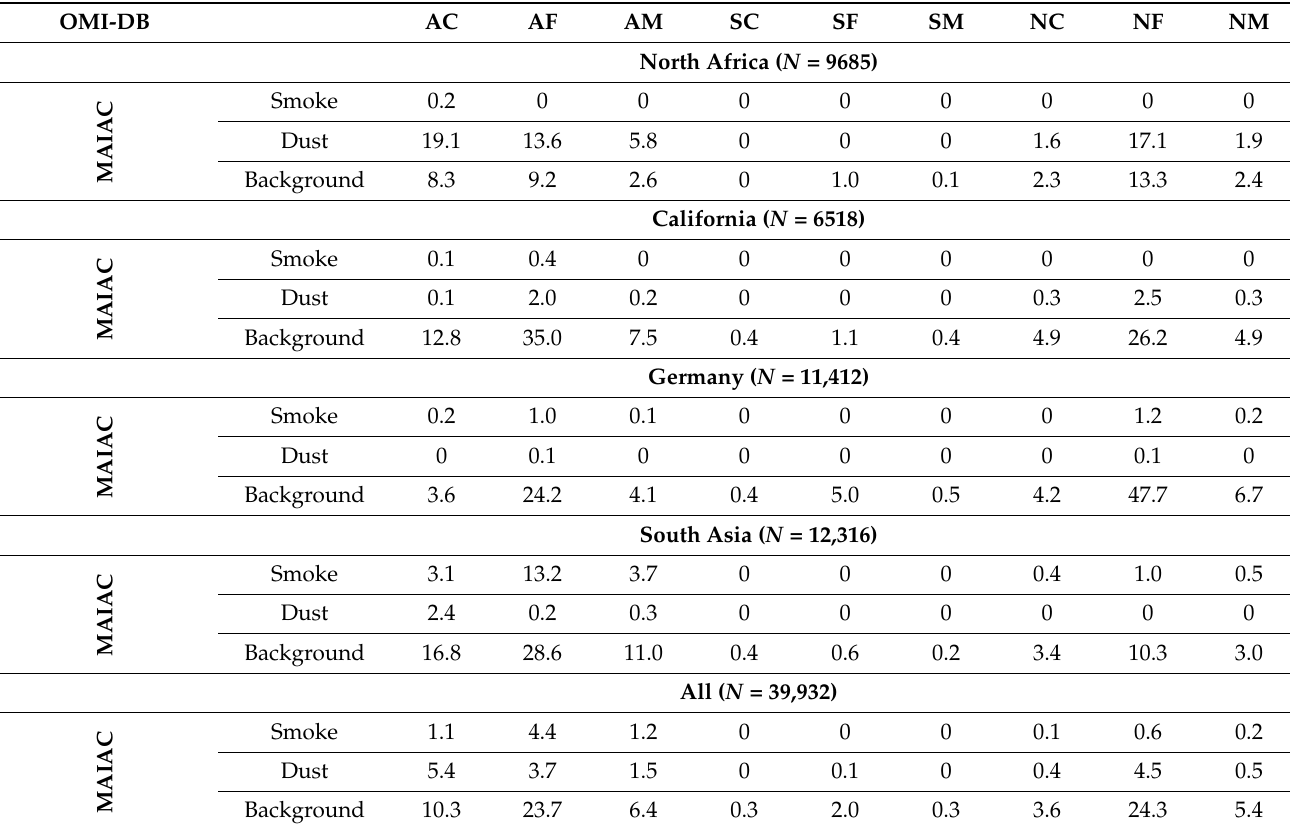
Table 3. Confusion matrixes of aerosol types retrieved by MAIAC and OMI-DB (%). The aerosol optomechanical size categories include AC, absorbing coarse; AF, absorbing fine; AM, absorbing mixed size; SC, scattering coarse; SF, scattering fine; SM, scattering mixed size; NC, neutral coarse; NF, neutral fine; and NM, neutral mixed size. Coarse aerosol: AE < 0.7; mixed size aerosol: 0.7 ≤ AE < 1.3; fine aerosol: AE ≥ 1.3. Scattering aerosol: AI < –0.25; neutral (mixed type) aerosol: –0.25 ≤ AI < 0.25; absorbing aerosol: AI ≥ 0.25 (see Section 3.2).